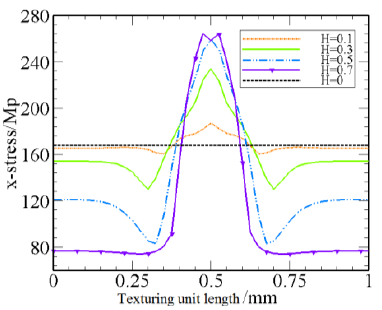
Figure 10. Distribution of stresses along the x –direction at different texturing depths and W = 0.1.